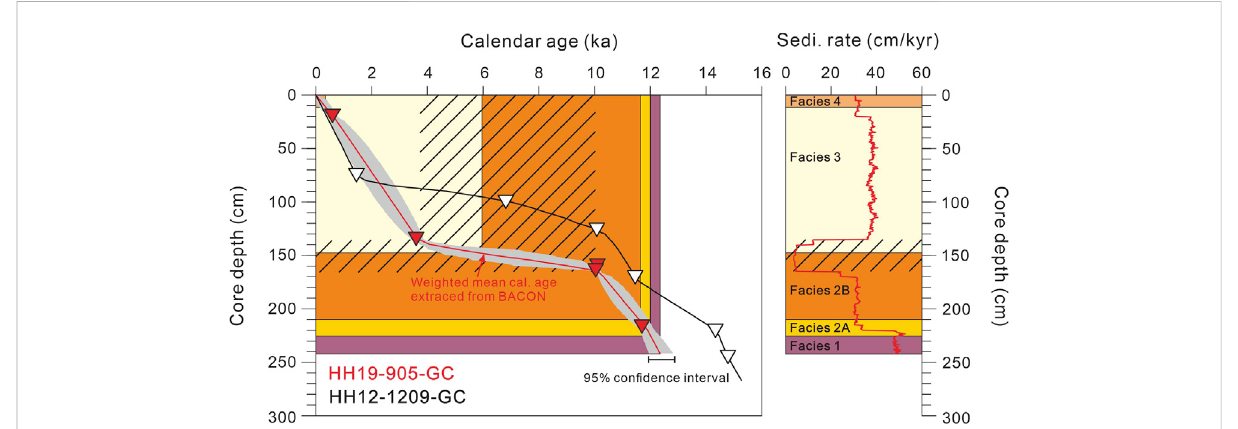
FIGURE 8 Comparison of sedimentation rates between Little Storfjorden (core 905) and eastern Storfjorden (HH12-1209-GC) based on the age model applying to the Marine 20 dataset (Heaton et al., 2020) and a regional reservoir age difference ( Δ R) of − 61 ± 37 (Pie ń kowski et al., 2021). The age- depth relationship was calculated using a BACON program. A dashed area indicates a zone of very low sedimentation rates in core 905.